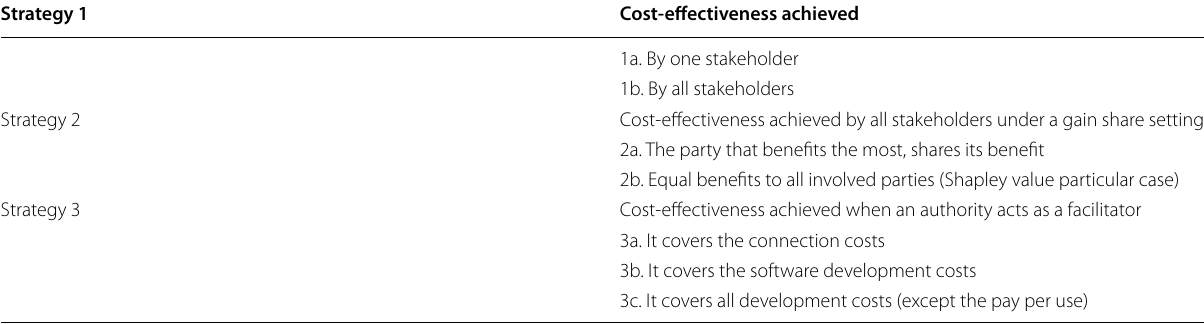
Table 2 Implementation strategies analysed. Source : own composition based on interviews Strategy